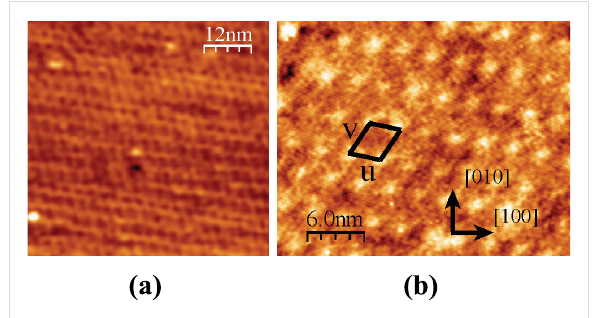
Figure 6: (a) Topographic and (b) Kelvin map of a high molecular coverage annealed to 150 °C; (c) and (d) are enlargements of the upper-left parts of (a) and (b) (blue rectangle). Δ f = − 20 Hz, A = 2 nm.